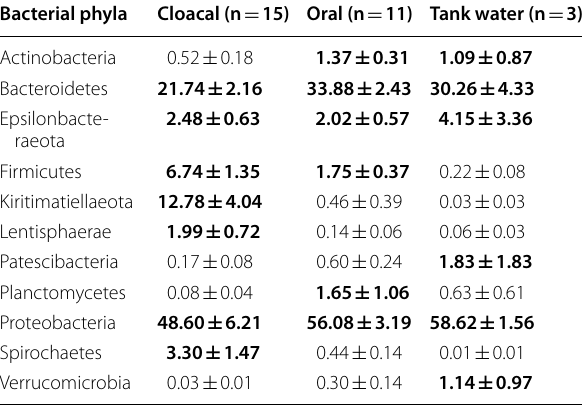
Values represent mean percentage